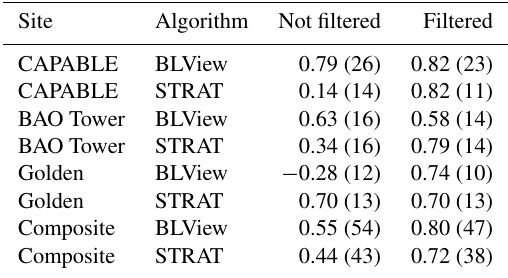
Table 5. Summary of statistics for the CL51/sonde MLH/ABL in- tercomparison, corresponding to Fig. 9. Numbers in parentheses in- dicate sample size. Composite statistics were generated by looking at all sites as a single data set. In this table only, the filtering method for the STRAT-based MLH is based on visual identification of false MLH values due to clouds/precipitation events and unusually clean atmospheres as described in